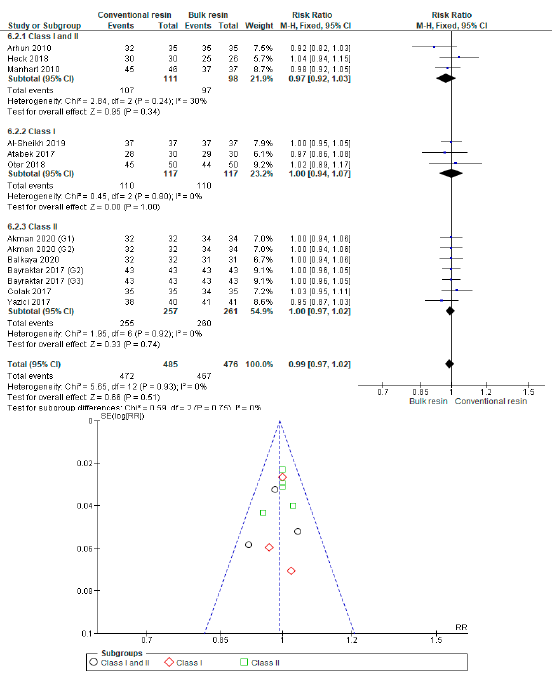
Figure A26. Adequate Color Stability and Translucency: Conventional Resin versus Bulk Resin Covered with Conventional Resin According to Type of Restoration.